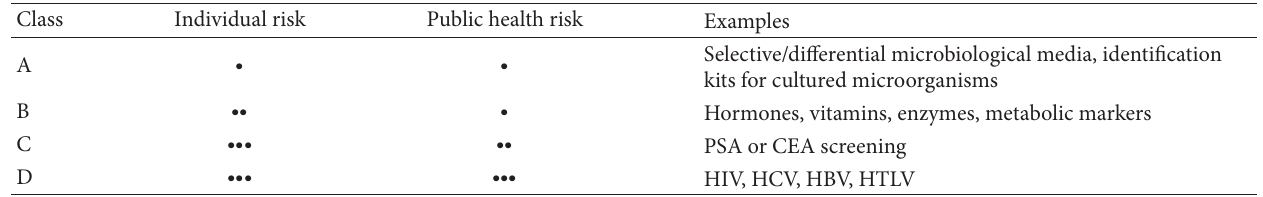
Table 1: General classification of